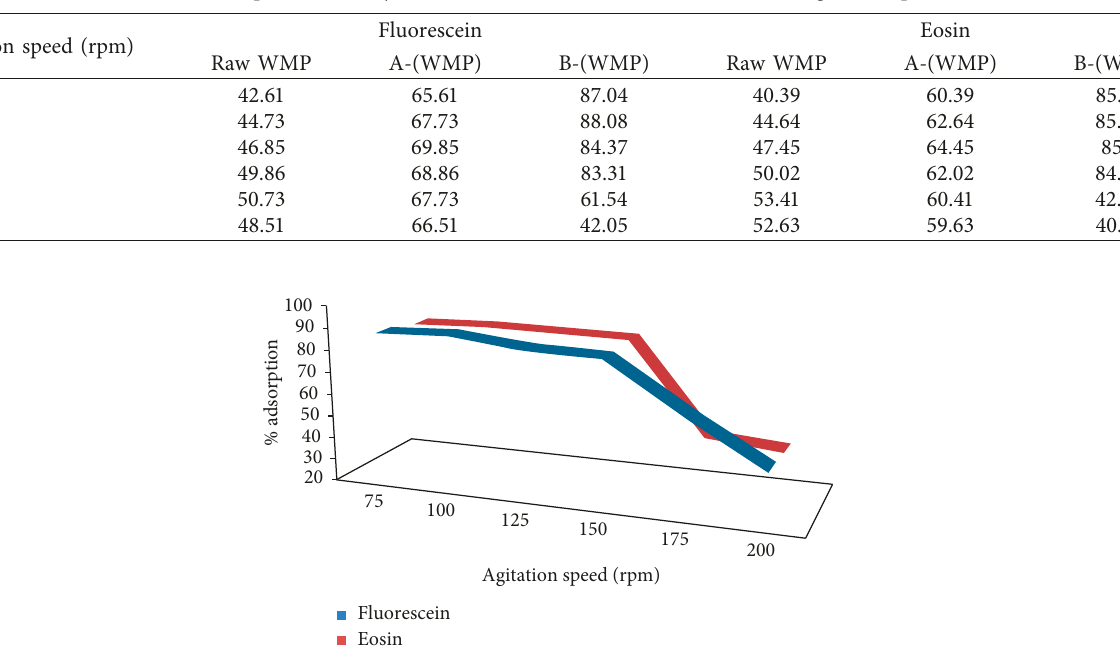
Figure 5: Comparative sorption efficiency of the base-treated WMP at different time intervals for removing fluorescein and eosin dyes. Table 4: Sorption efficiency of the sorbent material (WMP) at different agitation speeds.